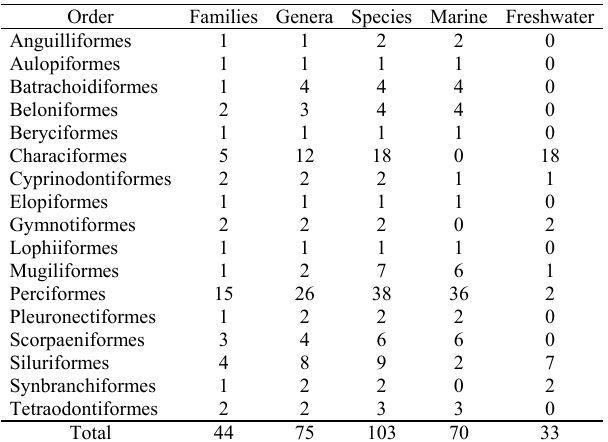
Table 1. Number of analyzed freshwater and marine Actinopterygii. Classification followed Eschmeyer & Fong